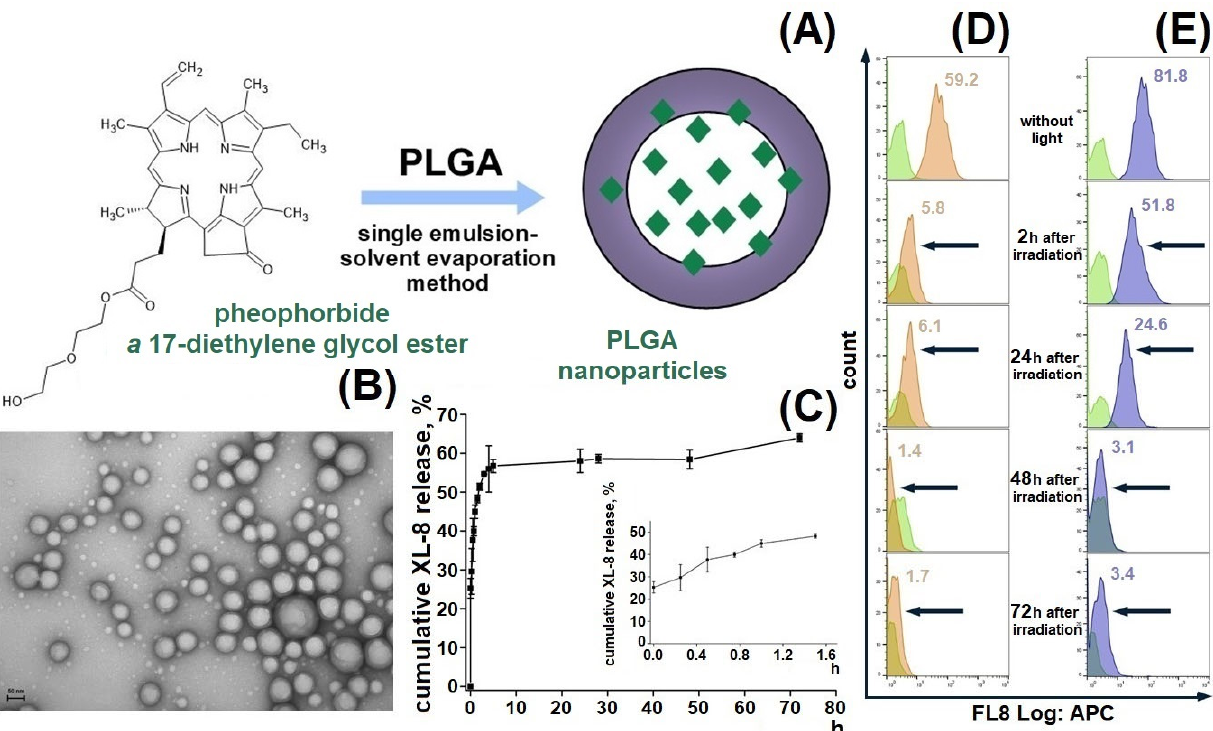
Figure 1. Formulation scheme of XL ‐ 8 ‐ loaded PLGA NPs ( A ) and TEM micrograph of XL ‐ 8 ‐ loaded NPs. Scale bar corre ‐ sponds to 50 nm ( B ). In vitro release of XL ‐ 8 ‐ loaded NPs in PBS (pH 7.4). Each point shows mean ± S.D. ( n = 3) ( C ). Flow cytometry analysis of HeLa cells treated with XL ‐ 8 (120 nM; orange) ( D ) and XL ‐ 8 ‐ NPs (120 nM; blue) ( E ) (not treated cells; green), irradiated and analyzed after 2 h, 24 h, 48 h, and 72 h. MFI of cells treated with XL ‐ 8 (orange numbers) and XL ‐ 8 ‐ NPs (blue numbers).